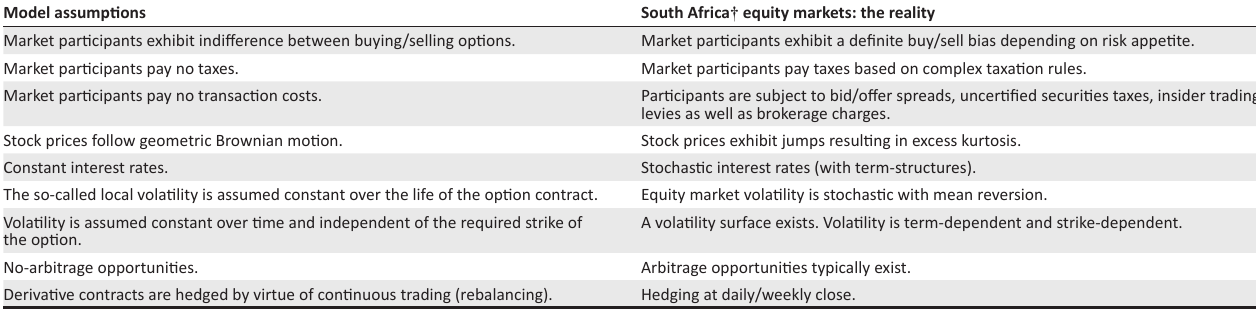
TABLE 1-A1: Black-Scholes paradigm and South African